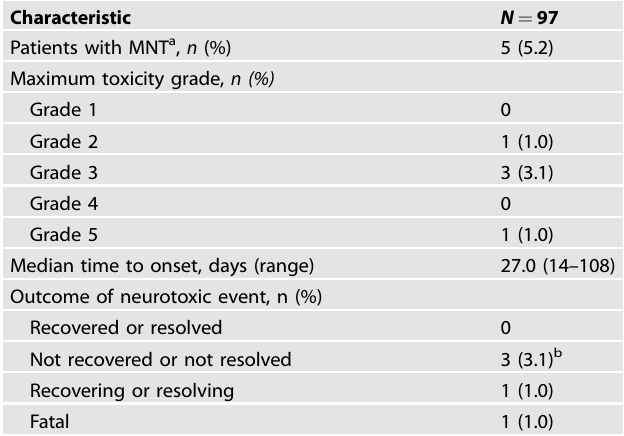
Table 2. Characteristics of MNTs in